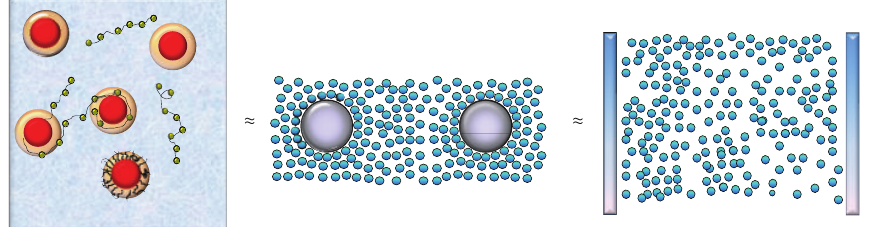
Figure 1: Model of interaction between colloidal particles of radius 𝑅 and solvent. The leftmost image represents a dispersion of colloidal particles (in red), coated with polymers, which are dispersed with polymer chains (in yellow). The central image illustrates the size difference between the colloids (in gray) and the solvent molecules (in cyan). Because of this size difference, colloidal particles can be considered as planar walls when modeling their interactions with the solvent, as shown in the rightmost image.